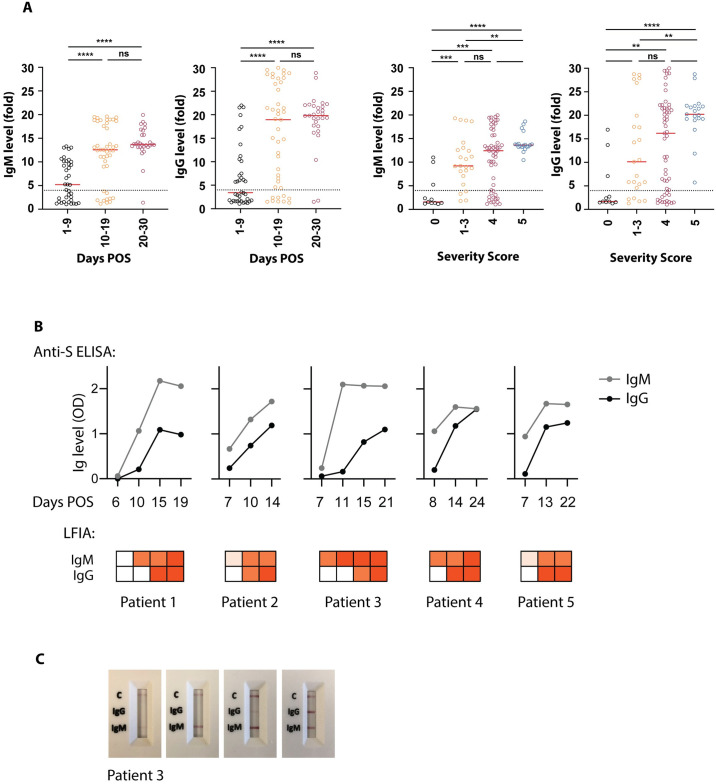
Antibody detection over increasing days POS and illness severity.(A) In-house ELISA results for anti-SARS-CoV-2 IgM and IgG were grouped by days POS and severity of illness, with 0 indicating mild illness (requiring no respiratory support) and 5 indicating critical (requiring ECMO) (see materials and methods for full classification). The 4-fold threshold for a positive result is shown as a dashed line on each graph. Median values are shown as red lines. (B) Sequential serum samples from five individuals were assayed for the development of anti-SARS-CoV-2 IgM and IgG. All five individuals were hospitalised with COVID-19 symptoms and confirmed positive for SARS-CoV-2 RNA by RT-PCR. A semi-quantitative in-house ELISA detecting anti-S antibodies (shown in graphs) and the SureScreen lateral flow assay (shown in heatmaps below the graphs) were compared for their detection of anti-SARS-CoV-2 in the same serum samples. Days POS are indicated for each sample. (C) Images of the lateral flow test results for patient 3 are shown.